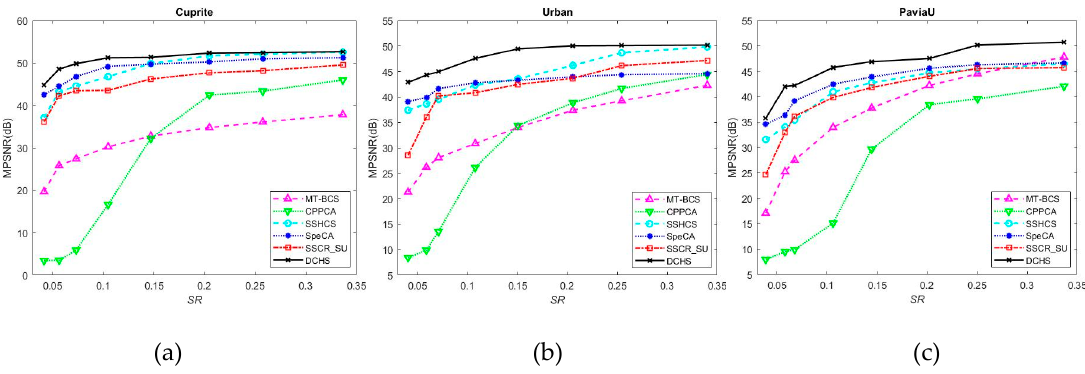
Figure 5. Mean peak signal-to-noise ratio (MPSNR) curves of different algorithms for different datasets: ( a ) Cuprite dataset, ( b ) Urban dataset, and ( c ) PaviaU dataset.